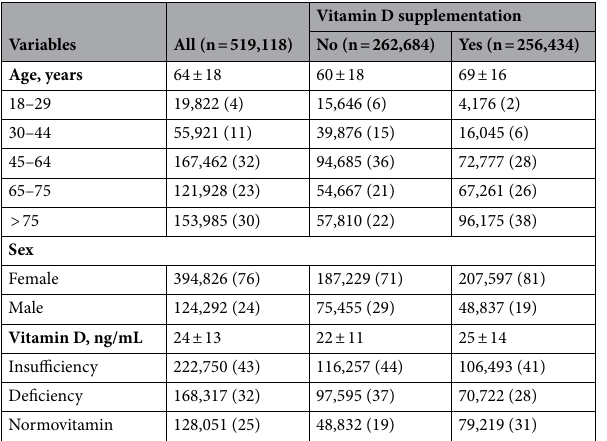
Table 1. Population characteristics and distribution by vitamin D levels and supplementation. Categorical variables are presented as absolute frequencies (percentages) and continuous variables as the mean ± standard